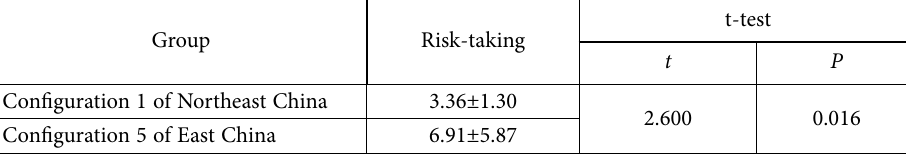
Table 7. Independent sample t-test of regional corporates’ risk-taking Group